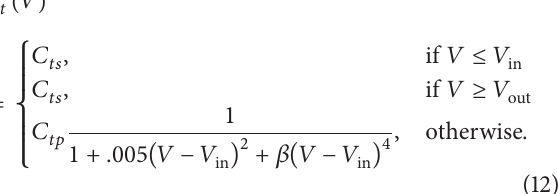
Figure 4: The average wind farm capacity factor CF for two particular deployments of CD = 2.5 Wm −2 , as a function of time. Theses plots show the details behind the points for CD = 2.5 Wm −2 in Figures 7 and 8. The average production with 8MW turbines is 106 GW. The average production with 2 MW turbines is